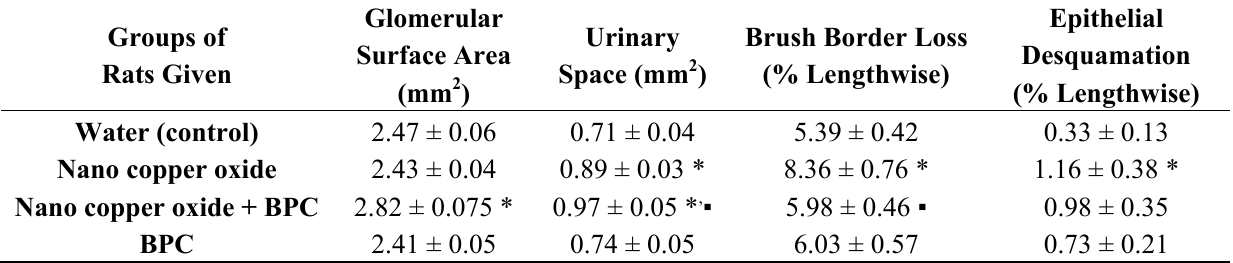
Table 2. Some morphometric indices for the status of kidneys in rats after repeat intraperitoneal injections of copper oxide nano-suspensions and/or oral administration of the BPC ( х ± S х